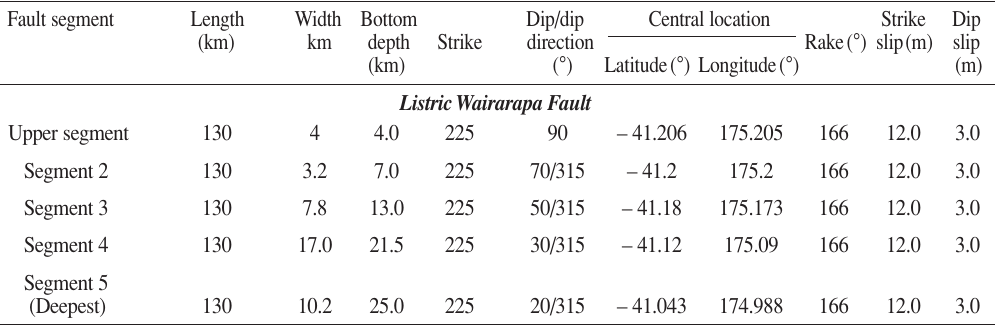
Table I. Model parameters for the 1855 Wairarapa earthquake (modified from Darby and Beanland, 1992). Fault